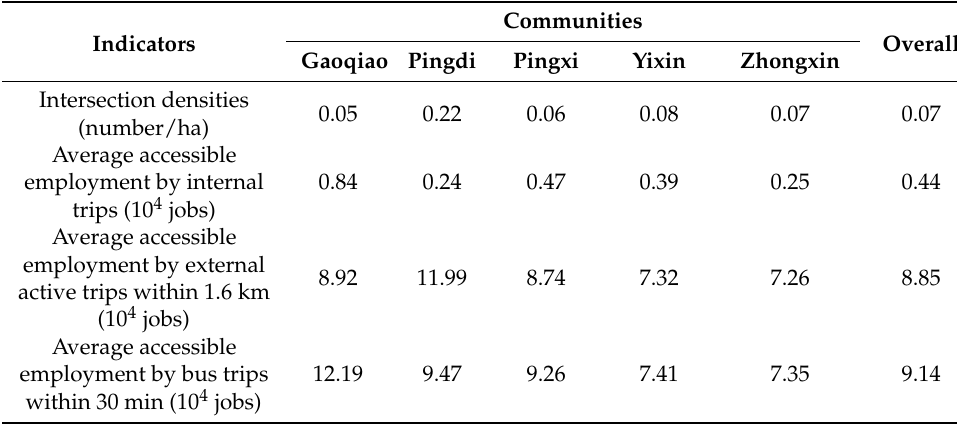
Table 6. Transport accessibility in the ILCC Core Area in